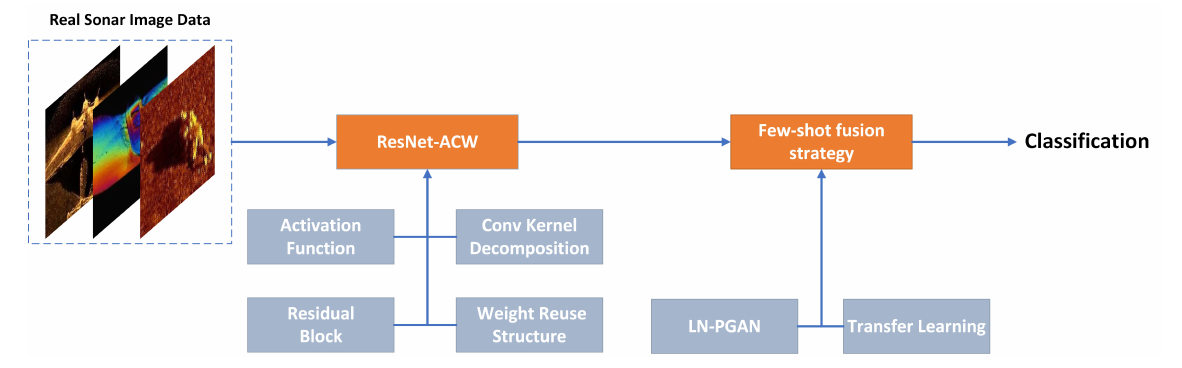
Figure 1. The context of this